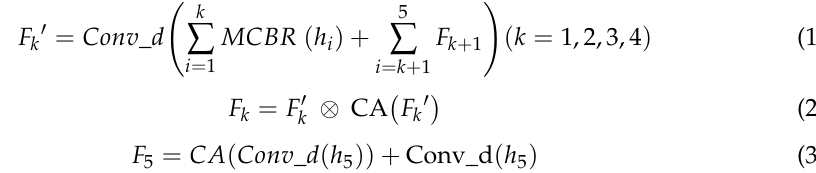
Figure 4. Structure of FFM. When it is FFM’s turn to work, it will process FA1 and FB1 together. In the processing process, the difference between them will be calculated first, then they will pass through a 3 × 3 convolution and be added to the original input, respectively; finally, they will be convolved separately and then added to obtain the output. The formulas are described as follows: